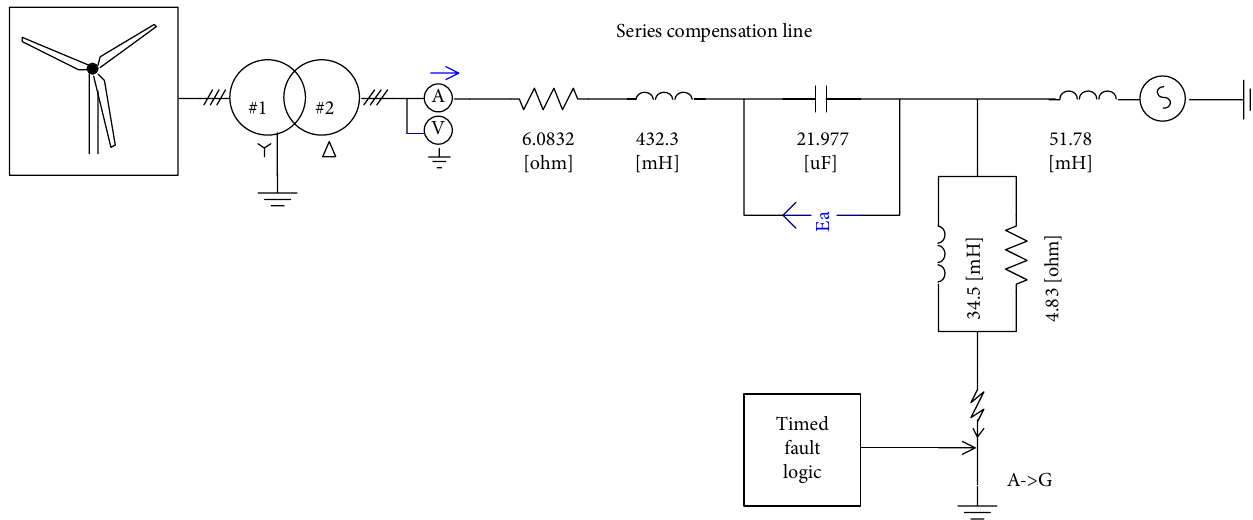
Figure 1: The PSCAD circuit diagram model of wind farm built based on IEEE second benchmark circuit model.